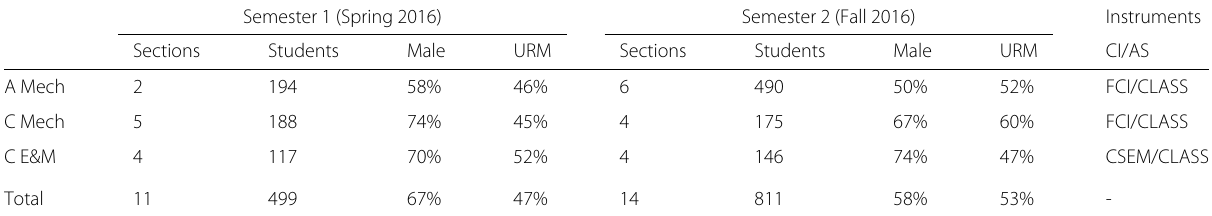
Table 2 Course demographic data and instruments